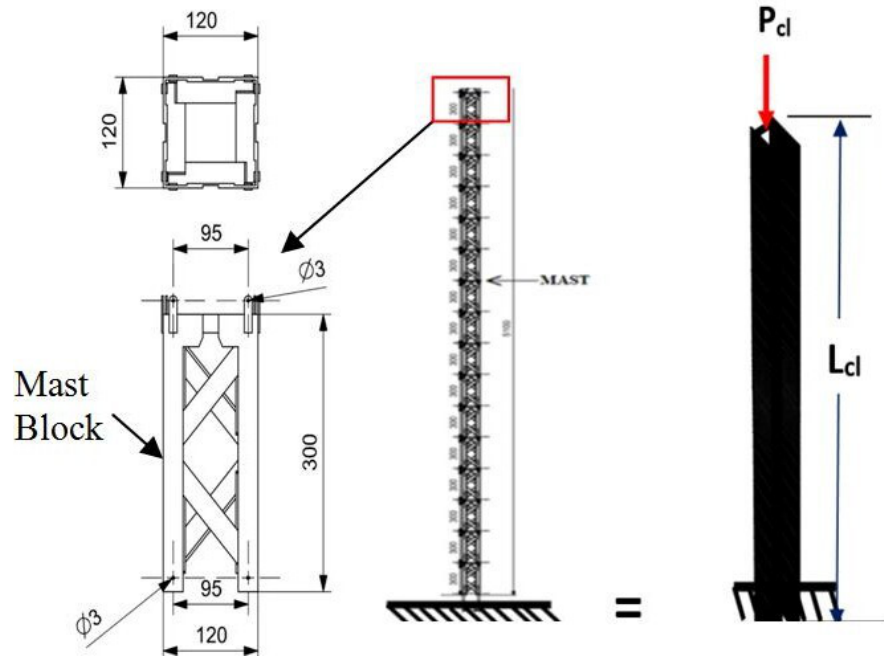
Figure 3. The mast is assumed in form of a